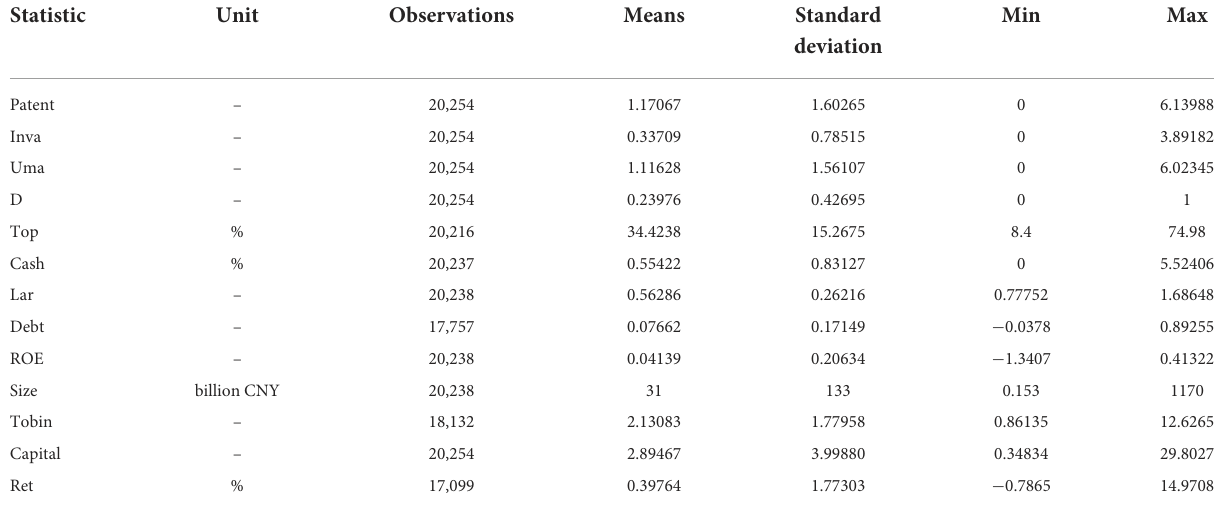
TABLE 2 Descriptive